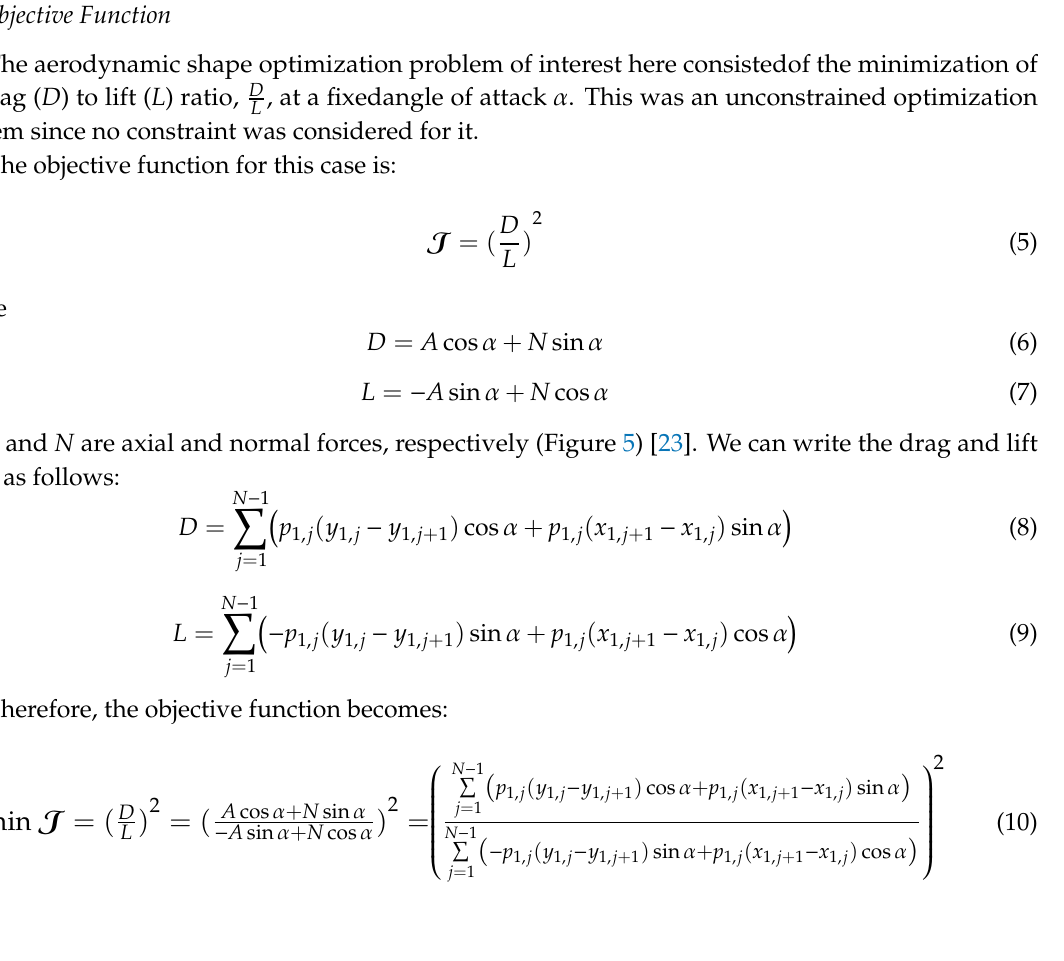
Figure 4. The values of the Bezier control points for the upper and lower surfaces of a NACA 0012 airfoil.